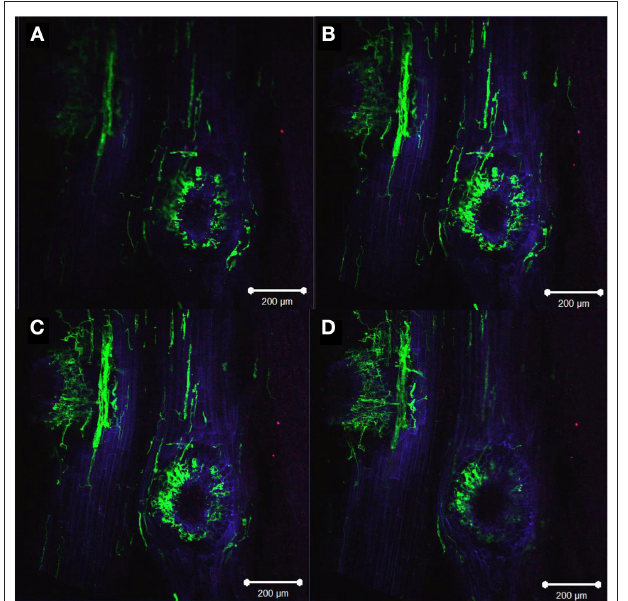
FIGURE 6 | Metarhizium anisopliae A1080 colonization of roots from two weeks old maize plants, showing the protrusion zone of secondary root emergence with fungi growing on the surface and inside the tissues. Overlay of images: plant membranes were stained with propidium iodide (blue) and Congo red (red), while fungal structures were stained with WGA-AF488 (green). Z-Stack image (A–D) : upper left image (A) distal focus, bottom right panel (D) closest focus (total distance 51.7 µ m). Images were taken with a confocal microscope (LSM 510 META–Zeiss) using the program ZEN 2009. The bar represents 200 µ m.